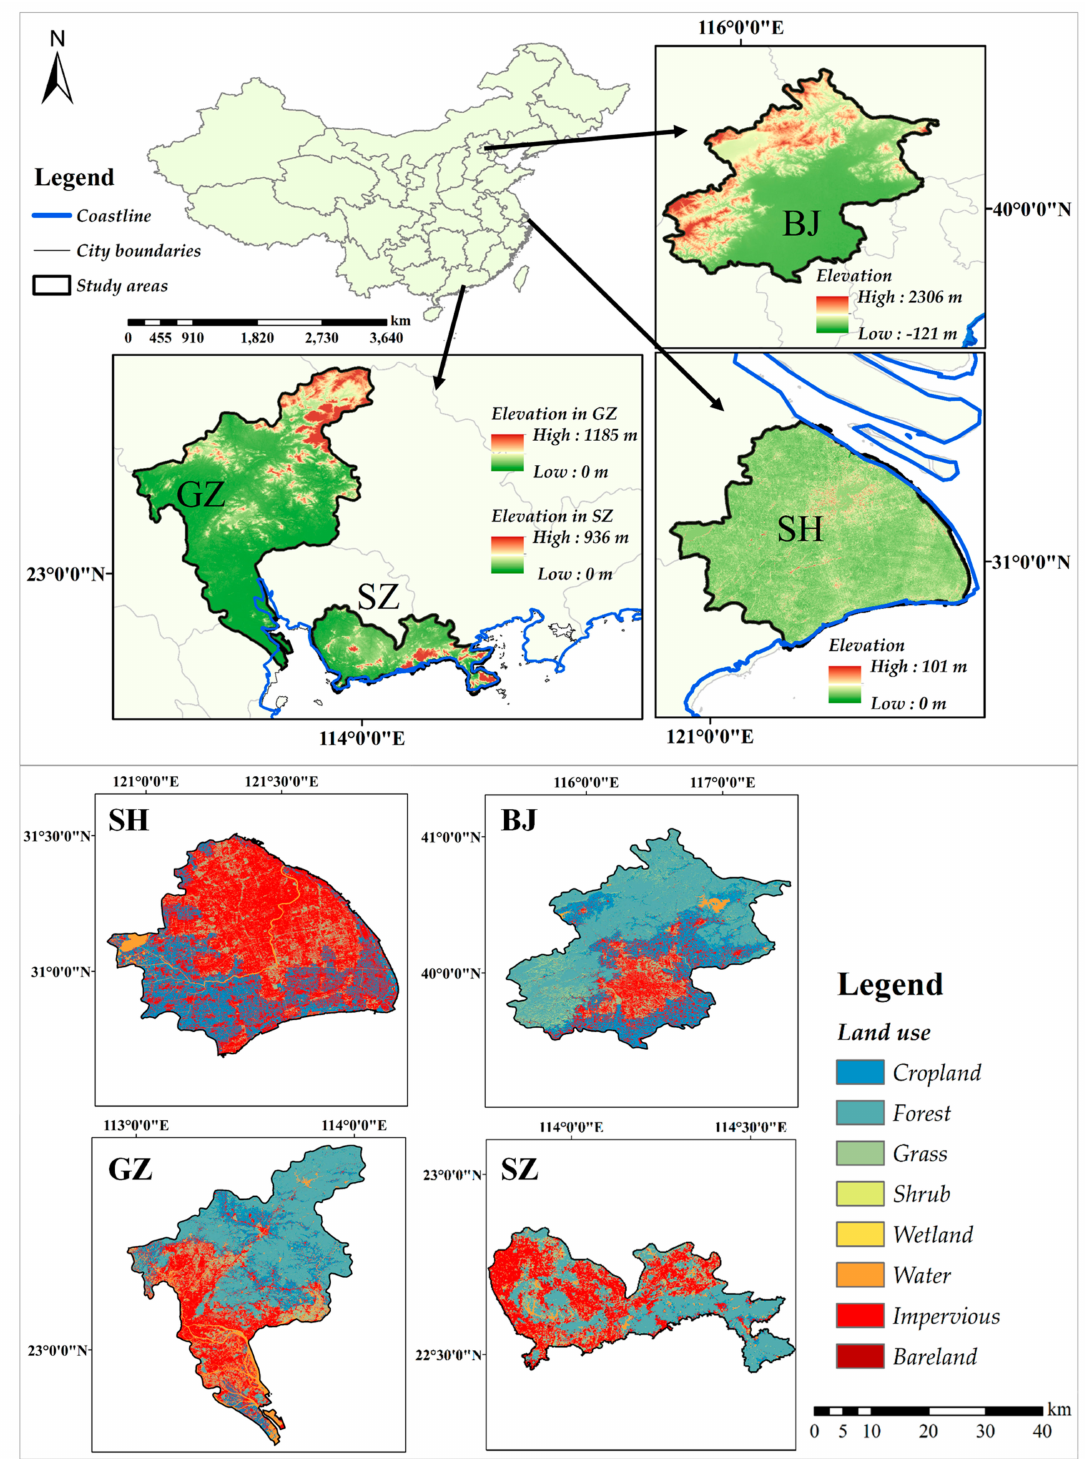
Figure 1. Location maps of the study areas with topography, city boundaries, and land